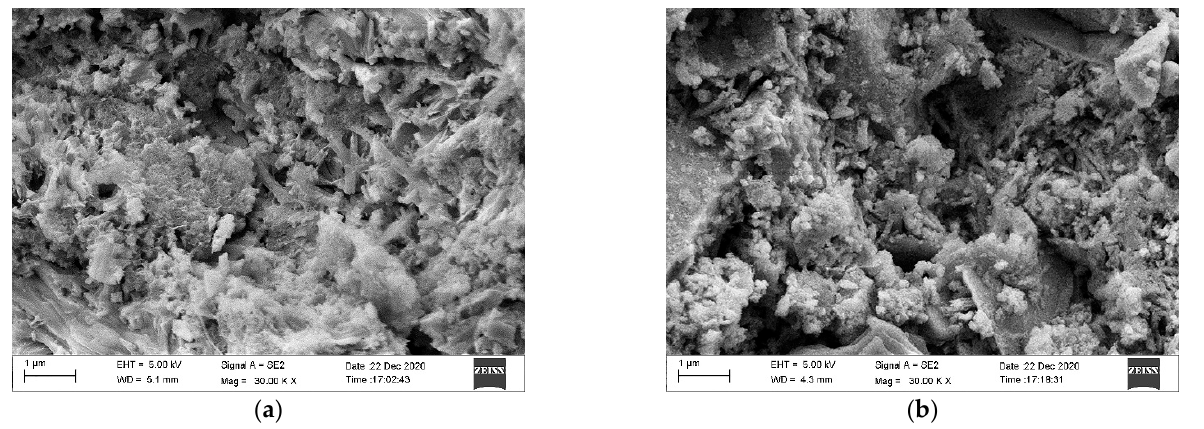
Figure 14. Before corrosion with hydrochloric acid. ( a ) D0 before corrosion with hydrochloric acid; ( b ) P2 before corrosion with hydrochloric acid.